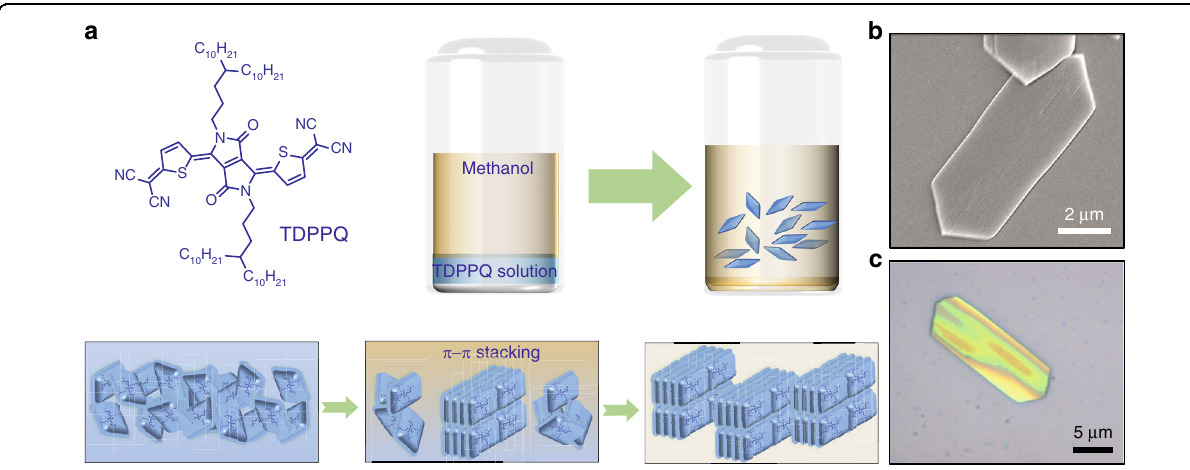
Fig. 1 The fabrication and characterization of the assembled TDPPQ nanosheet. a The chemical structure of the TDPPQ and schematic illustration of the solvent-phase interfacial self-assembly method to grow TDPPQ nanosheets. b The typical SEM image of the TDPPQ nanosheet fabricated from 0.1 mg/mL TDPPQ solution. c The typical optical image of the TDPPQ nanosheet fabricated from 0.1 mg/mL TDPPQ